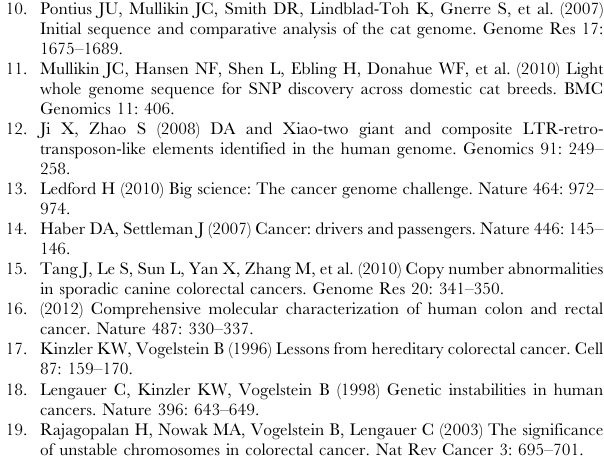
Substitution type